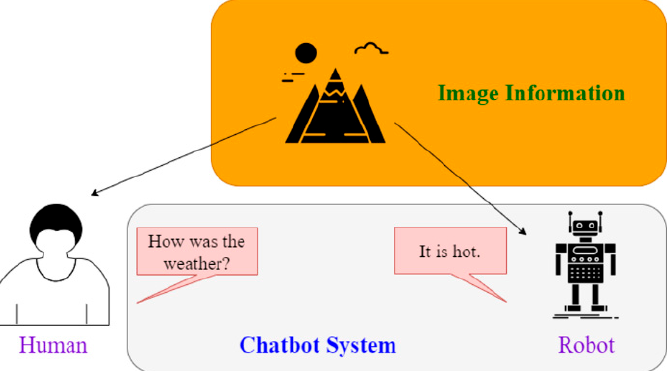
Figure 2. The concept of the proposed framework.